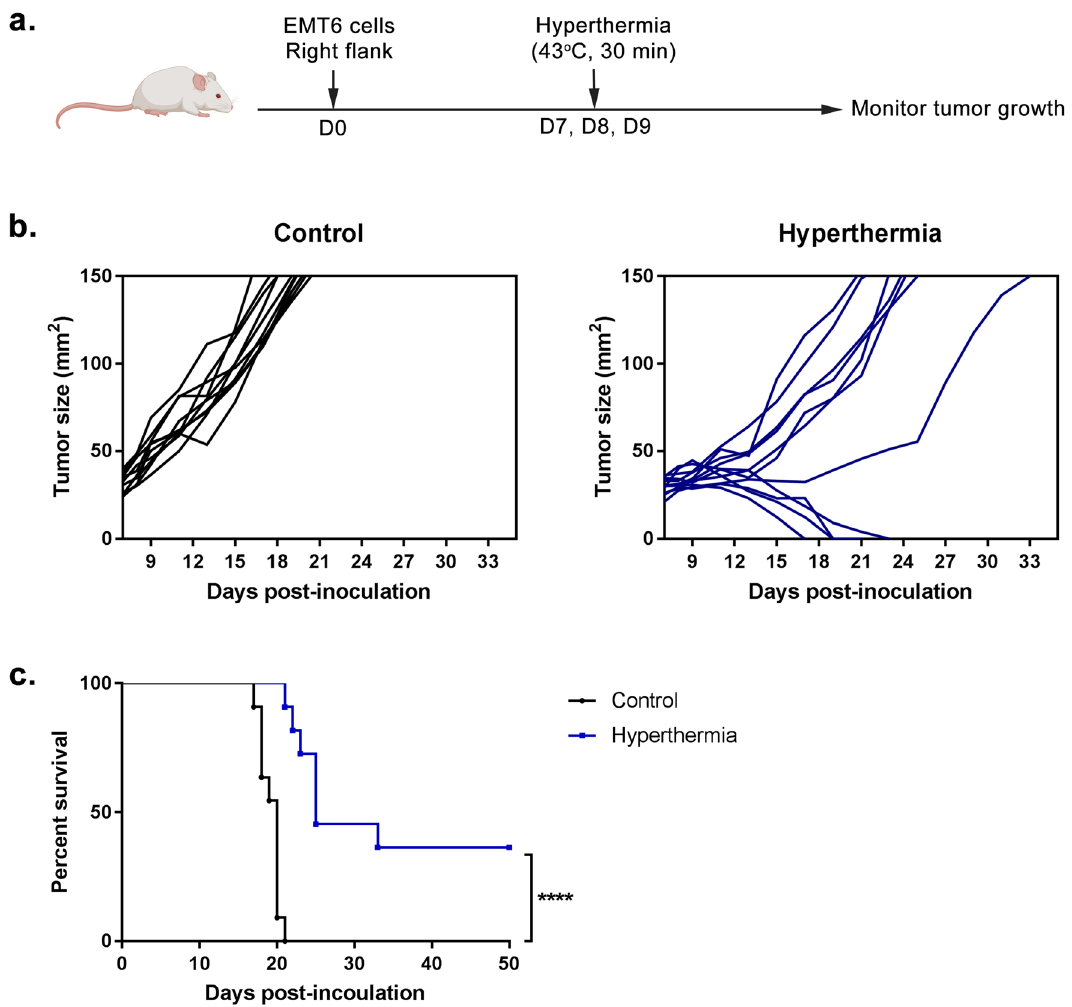
Figure 1. Local hyperthermia by NIR reduces tumor growth in tumor-bearing mice. ( a ) Schematic time course to study EMT6 tumor progression following treatment. ( b ) Line graph depicting the individual tumor growth in control and treated group ( c ) Survival curves of mice in 50 days after treatment. n = 11 per group. **** P < 0.0001 (Mantel-Cox